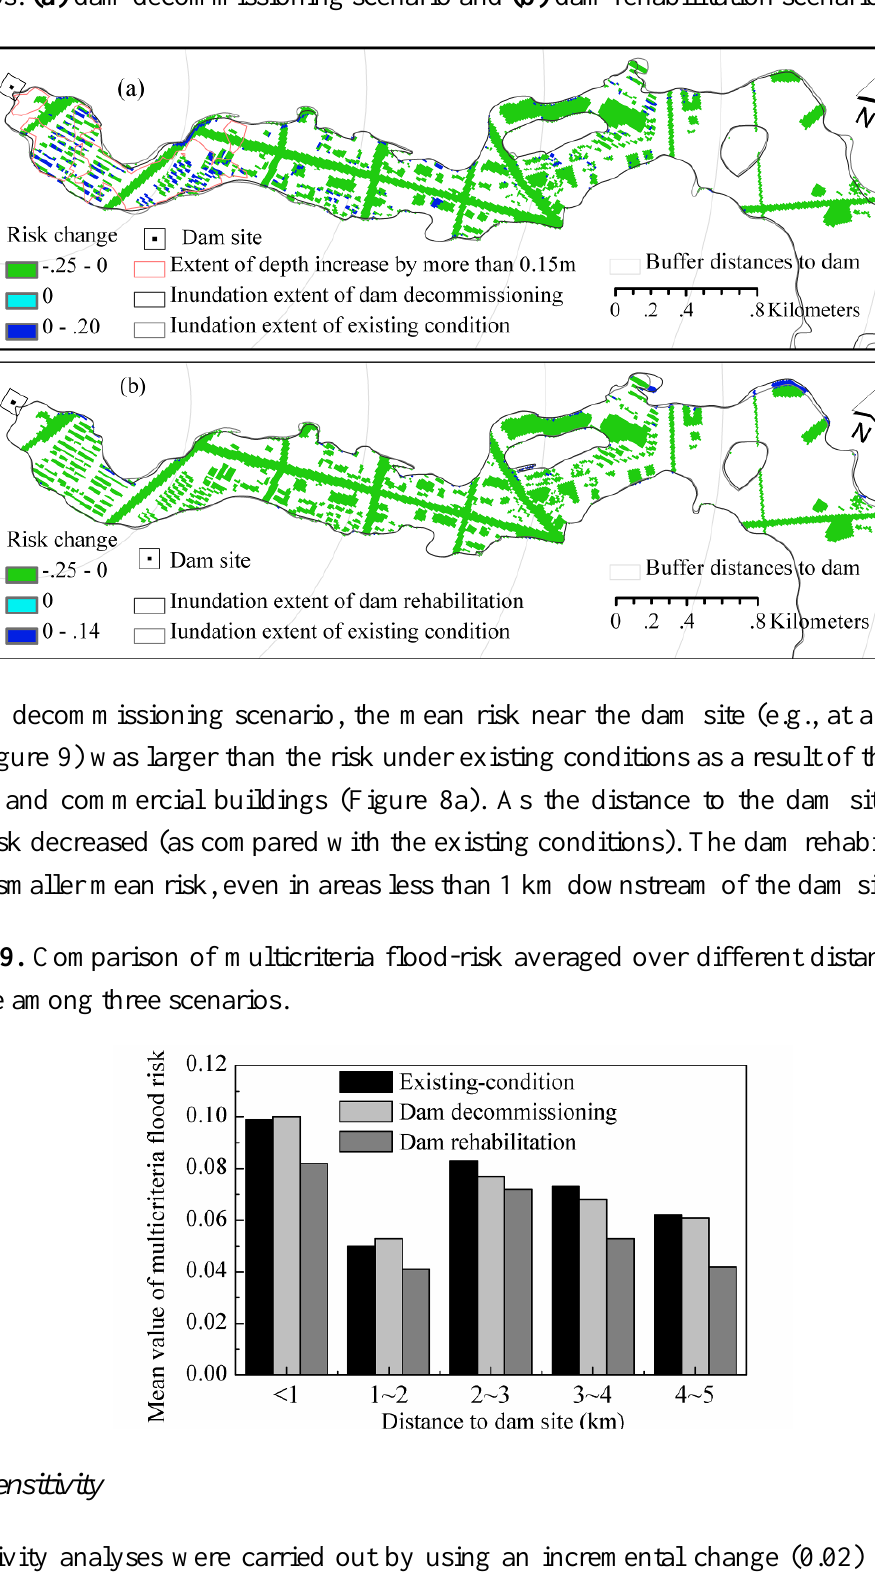
Figure 8. Changes of multicriteria flood risk from risk under existing conditions in two scenarios: (a) dam decommissioning scenario and (b) dam rehabilitation scenario.